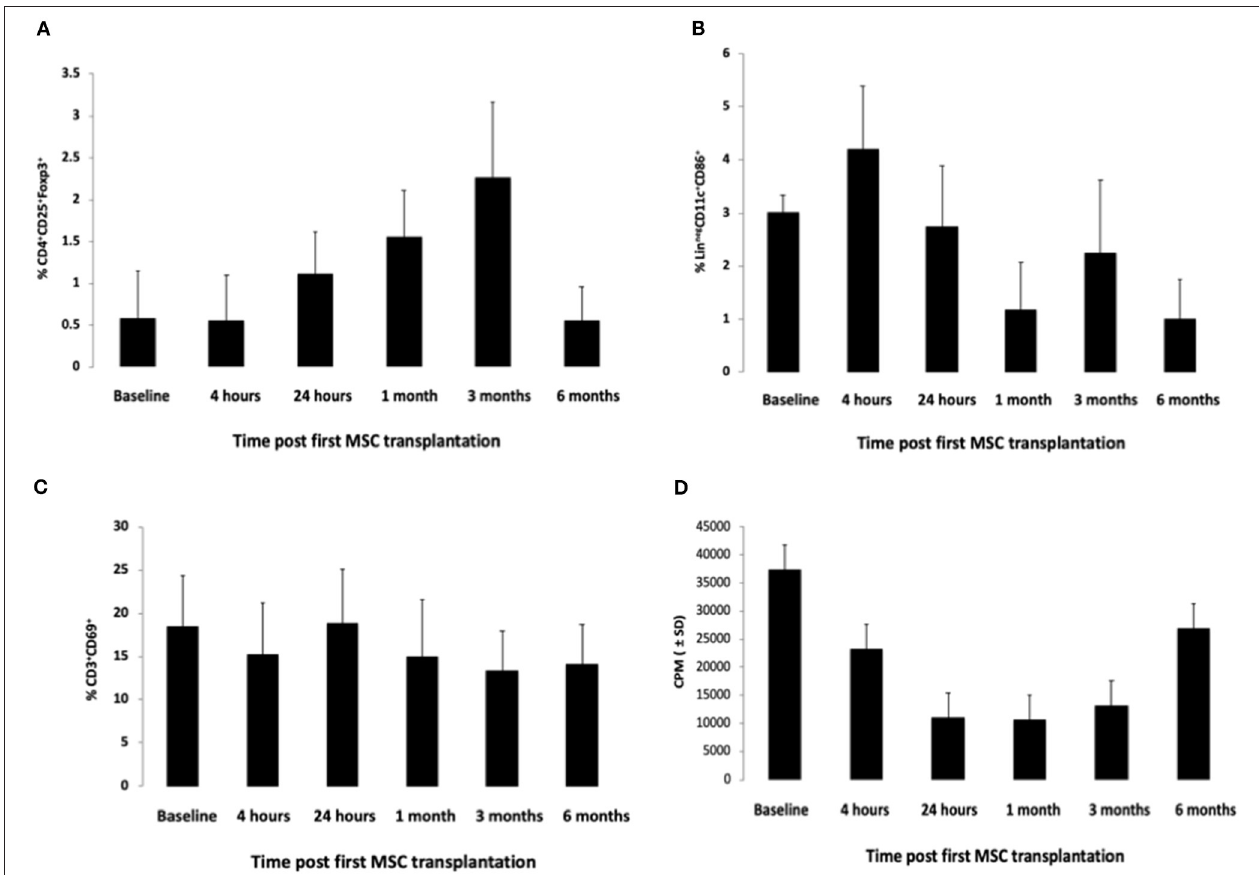
FIGURE 4 | Immunological changes following MSC transplantation at various time points during the 6 months following the first MSC transplantation. (A) Changes in CD3-gated, CD4 + CD25 high + Foxp3 + cells (mostly T-regs), at various time points following the first MSC transplantation. P = 0.002 at 4h vs. baseline, p = 0.0034 at 24h, p = 0.002 at 1 month, p = 0.0007 at 3 months, nonsignificant at 6 months (Wilcoxon signed rank test) ( n = 8). (B) Changes in Lin-CD11c + CD86 + cells (representing antigen-presenting cell populations, mostly dendritic cells, but also macrophages), at various time points following the first MSC transplantation. P = 0.0002 at 1 month vs. baseline, others not statistically significant (Wilcoxon signed rank test) ( n = 8). (C) Changes in CD3 + CD69 + cells (mostly activated lymphocytes), at various time points following the first MSC transplantation. P = 0.029 at 3 months vs. baseline, others not statistically significant (Wilcoxon signed rank test) ( n = 8). (D) Changes in the ex vivo proliferative ability of lymphocytes upon stimulation with phytohemagglutinin (PHA), at various time points following the first MSC transplantation. P = 0.001 at 4h vs. baseline, p = 0.0002 at 24h, p = 0.0009 at 1 month, p = 0.003 at 3 months, not statistically significant at 6 months (Wilcoxon signed rank test) ( n =